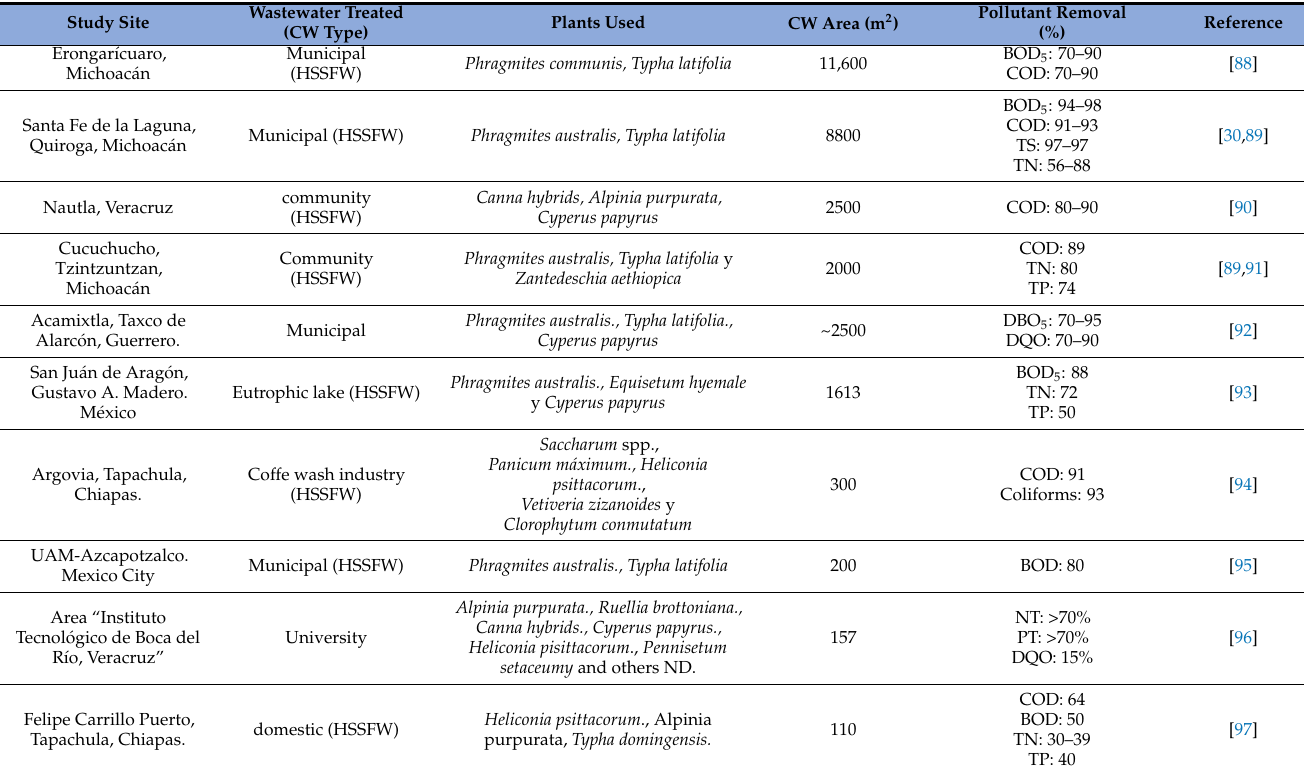
Table 1. Full-scale constructed wetlands in